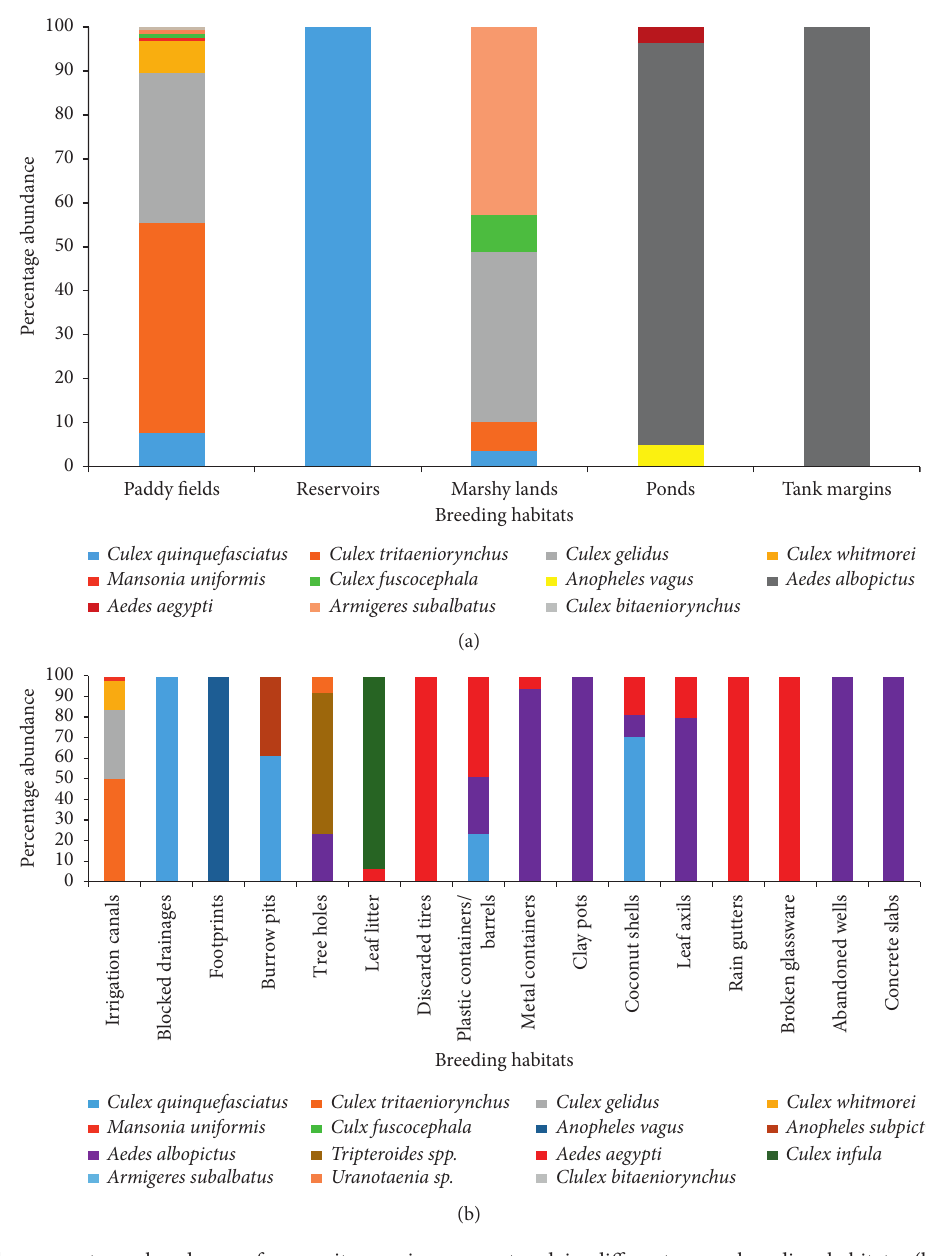
Figure 4: (a) The percentage abundance of mosquito species encountered in different macrobreeding habitats. (b) The percentage abundance of mosquito species encountered in different microbreeding